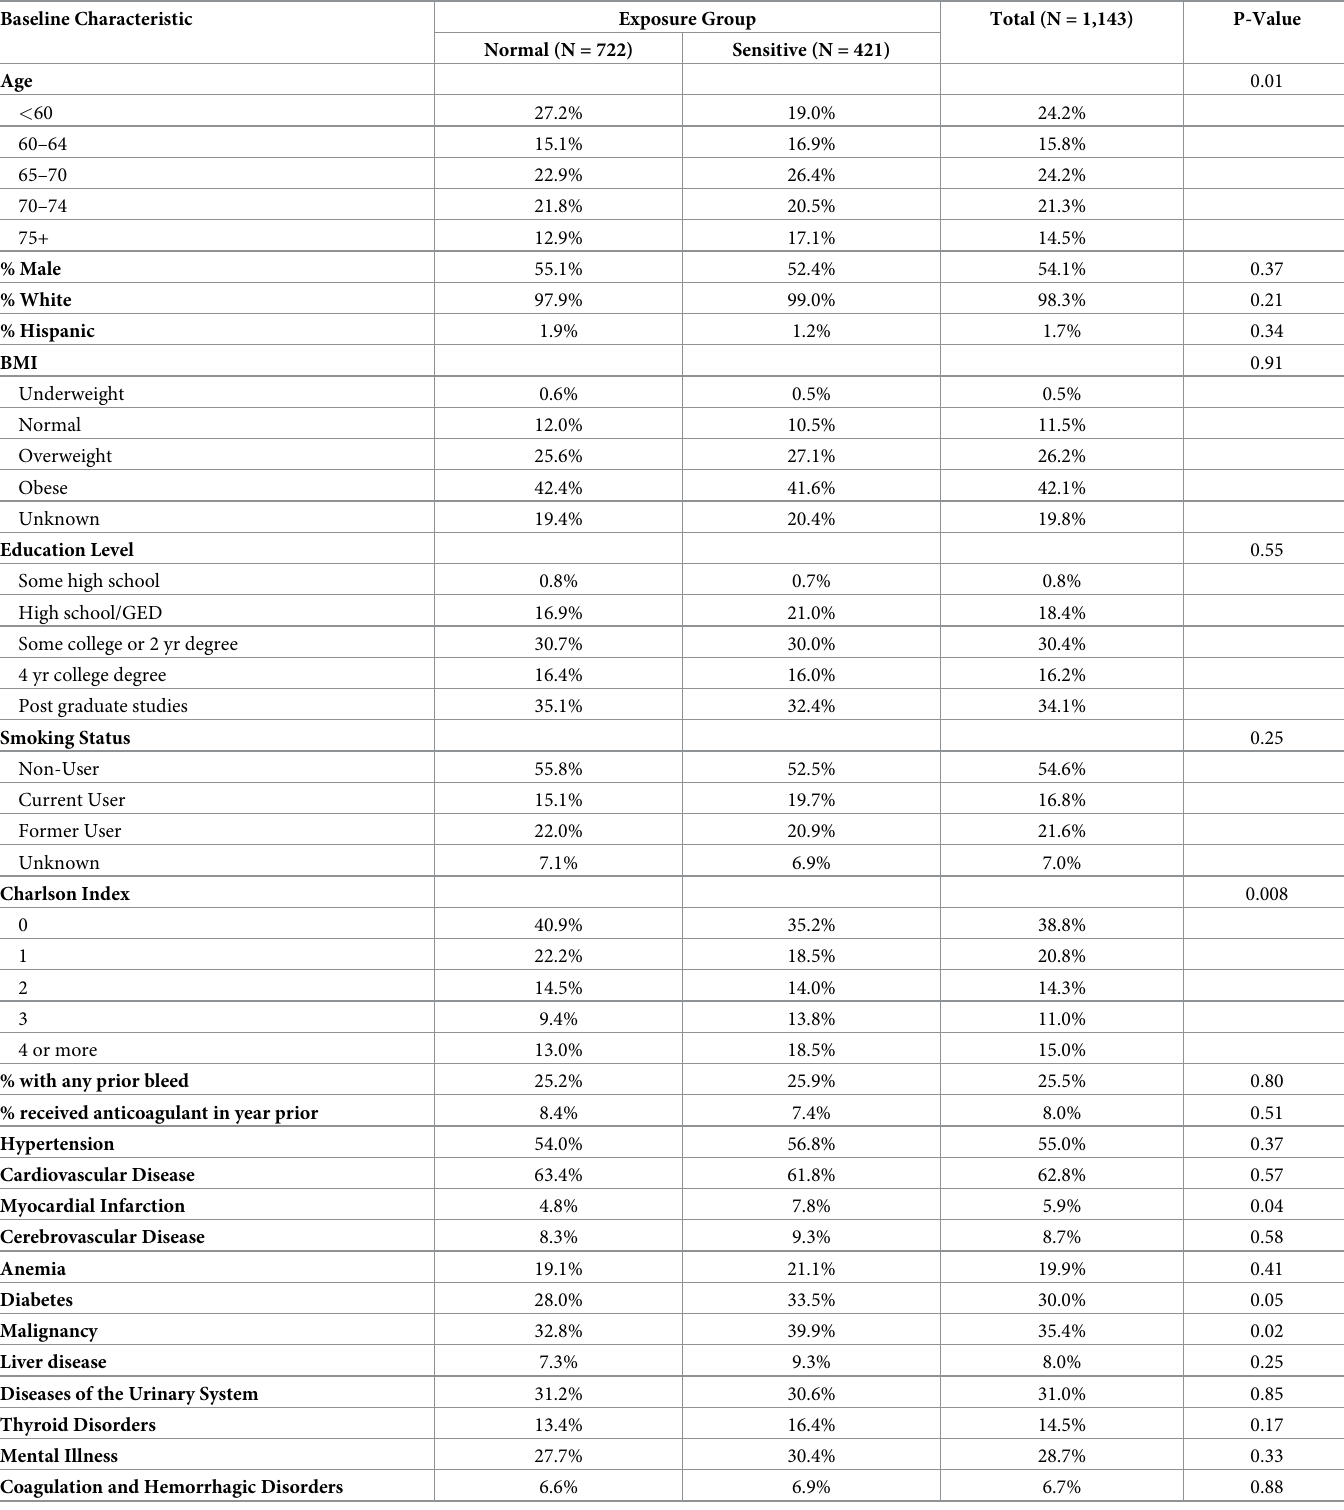
Table 2. Comparison of baseline characteristics across exposure